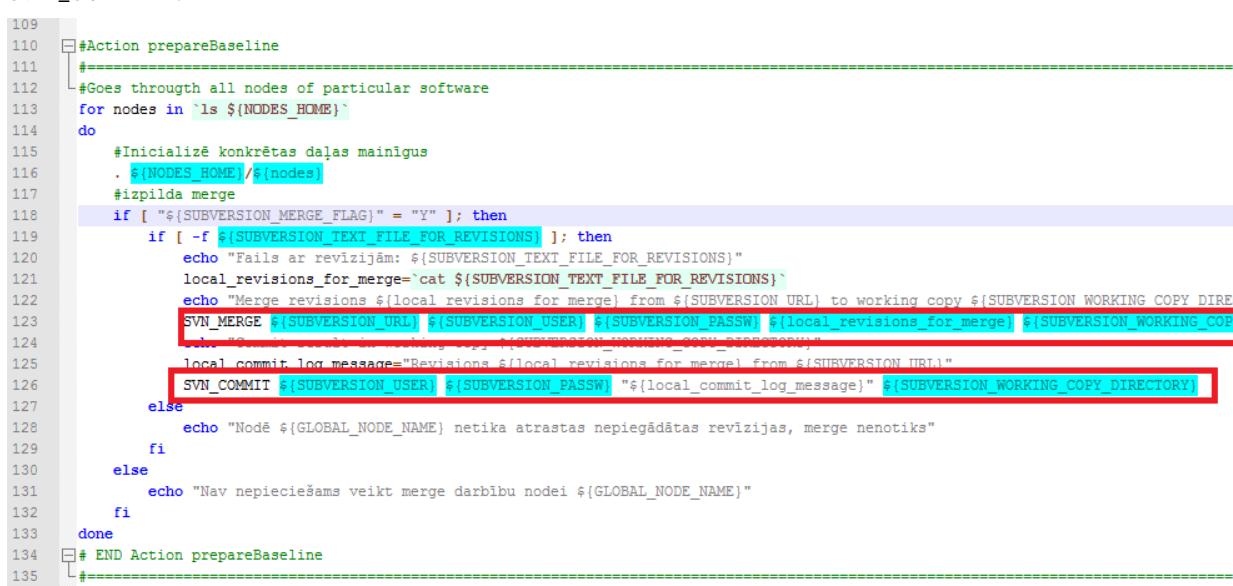
Fig. 6. Algorithm of action prepareBaseline() in script